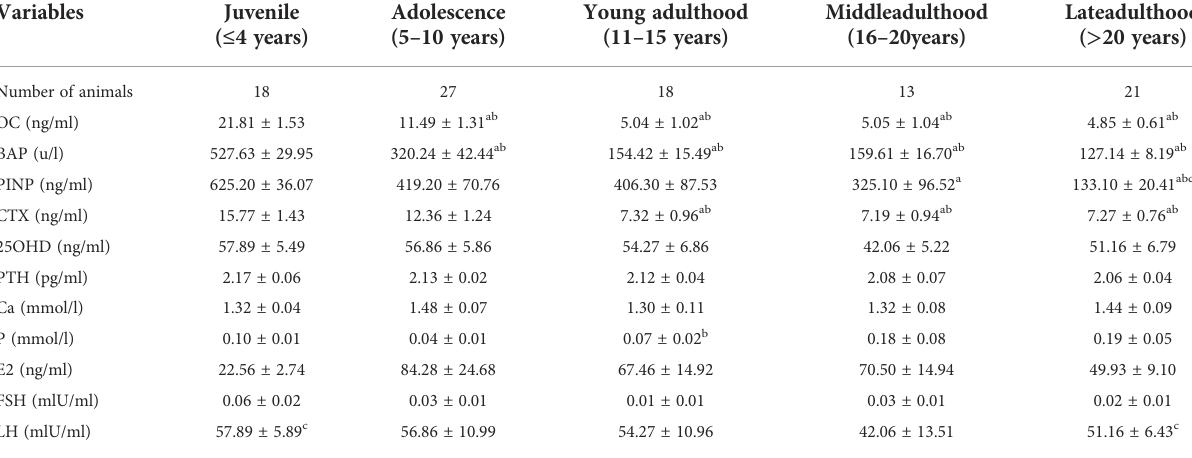
TABLE 2 Values of each indicator at each age group.